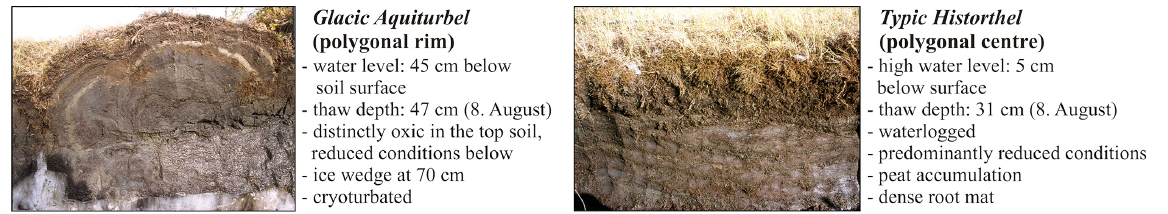
Figure 13. Two examples of permafrost-affected soils from Samoylov Island with a brief description of soil properties. The presented soil complex consisting of Glacic Aquiturbels and Typic Historthels dominates the soils of this island in the Lena River Delta (see Fig. 11).